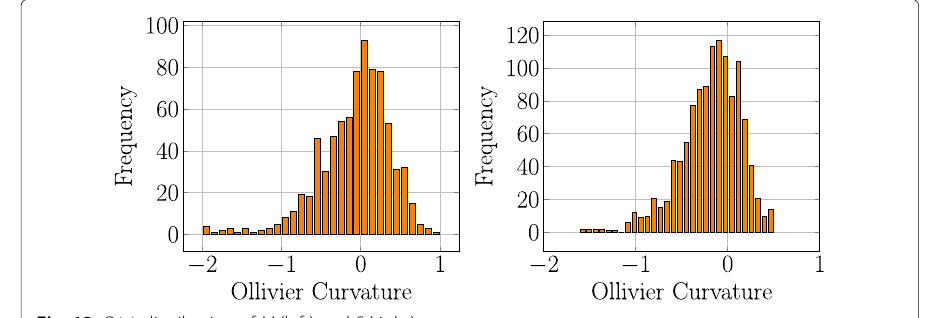
Fig. 13 O ( e ) distribution of M (left) and S